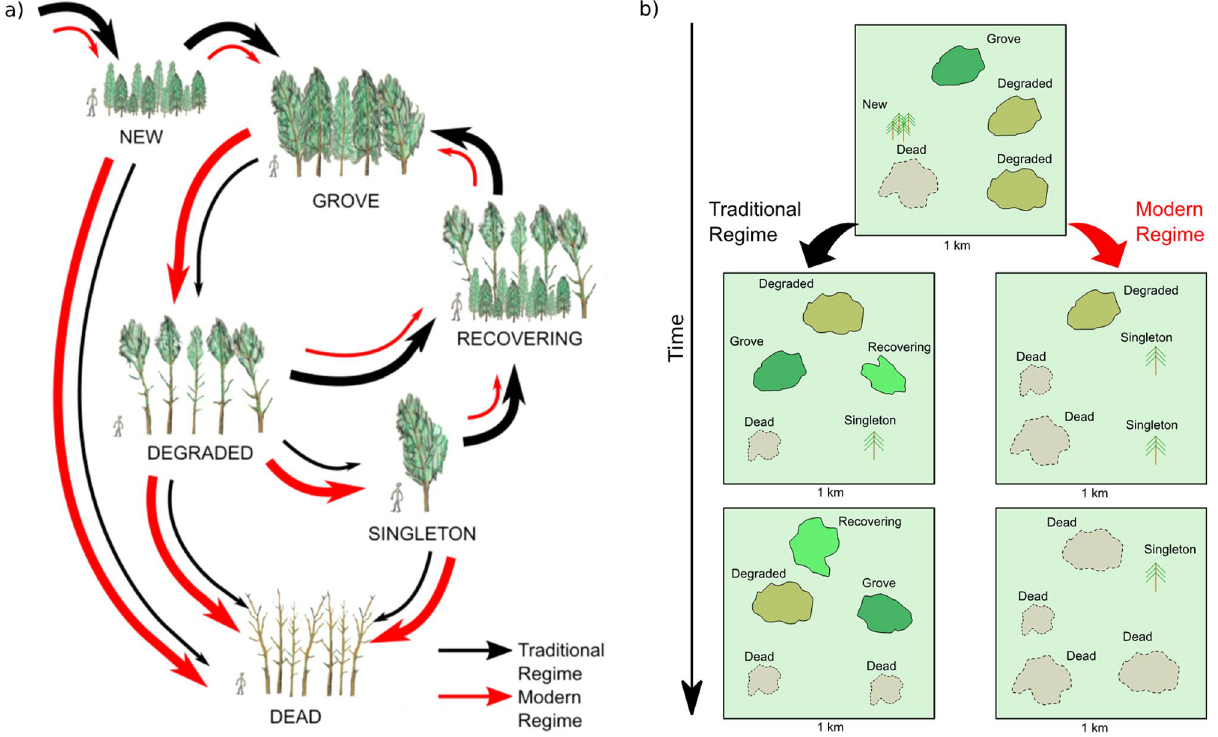
Figure 8. Conceptual model of the stand and spatial dynamics of Callitris intratropica on sand sheets on the Arnhem Plateau, based on a synthesis of results from this and previous publications (see main text for details) . ( a ) Small C. intratropica groves (stands) fluctuate in size and structure in response to fire damage which affects the ability of groves to exclude flammable grasses. The incursion of grasses into the stands allows fires to repeatedly burn into the groves. Once degraded, groves often die or are reduced to single isolated trees within a relatively short period of time. Singleton trees eventually die or, if fire frequency is reduced, can lead to the development of a new fire-excluding grove. Seed dispersal can also lead to new groves if seedling cohorts are able to establish in areas free from fire for several decades. In the diagram, the width of each arrow reflects our approximation of likely probability of the transition between the various states. ( b ) Under traditional Aboriginal fire regimes, the stand dynamics result in an ever-shifting mosaic of groves and singleton trees on fire exposed Eucalyptus sand sheet savannas. Under the modern fire regime of Kakadu National Park, the frequency and intensity of fires has increased such that the groves have been destroyed and most singleton trees on sand sheets have died. This is a gradual process that commenced in the twentieth century following the breakdown of traditional Aboriginal fire management. We suspect that complete elimination of C. intratropica on fire-exposed sand sheets is likely in the next few decades under current fire